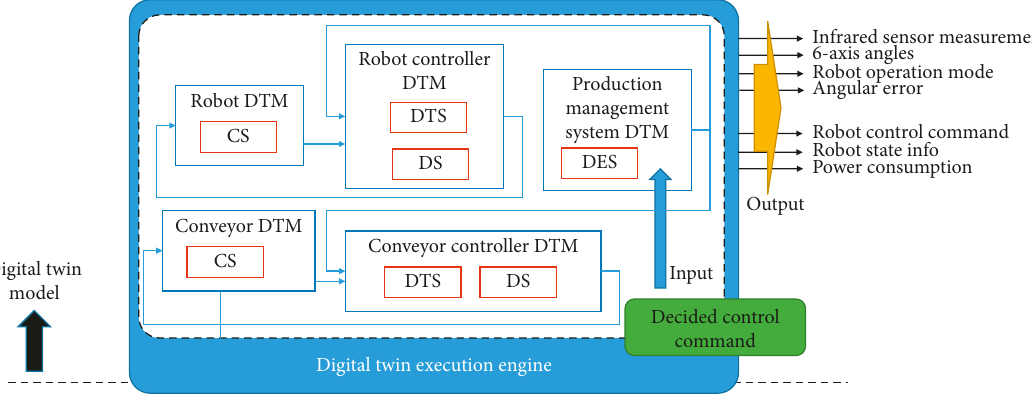
Figure 6: Simulation scenario of DigTwinOps